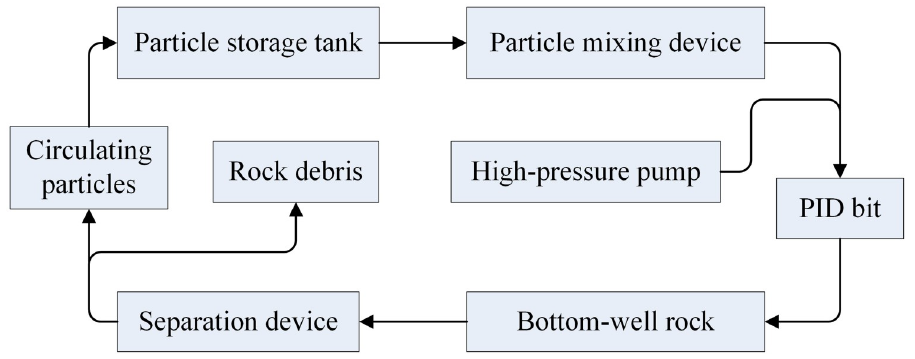
Fig 2. The rock-breaking process of particle jet coupled